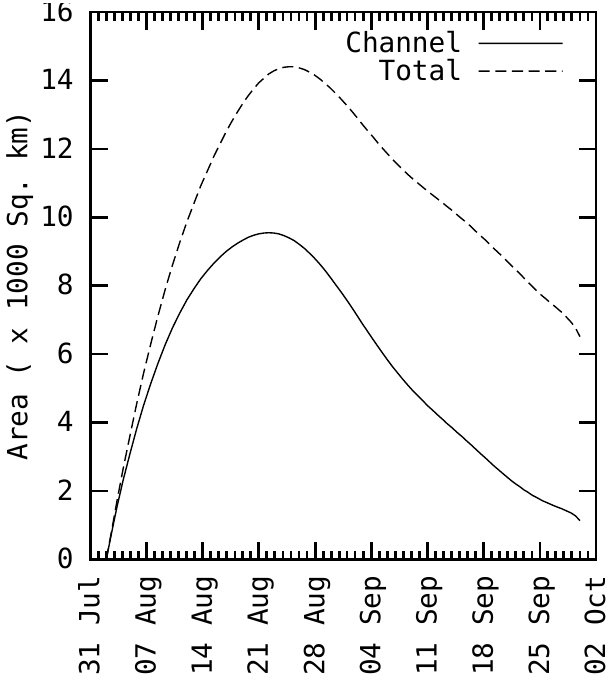
Fig. 19. Area of inundation over time, of the Indus Channel and the total flood.